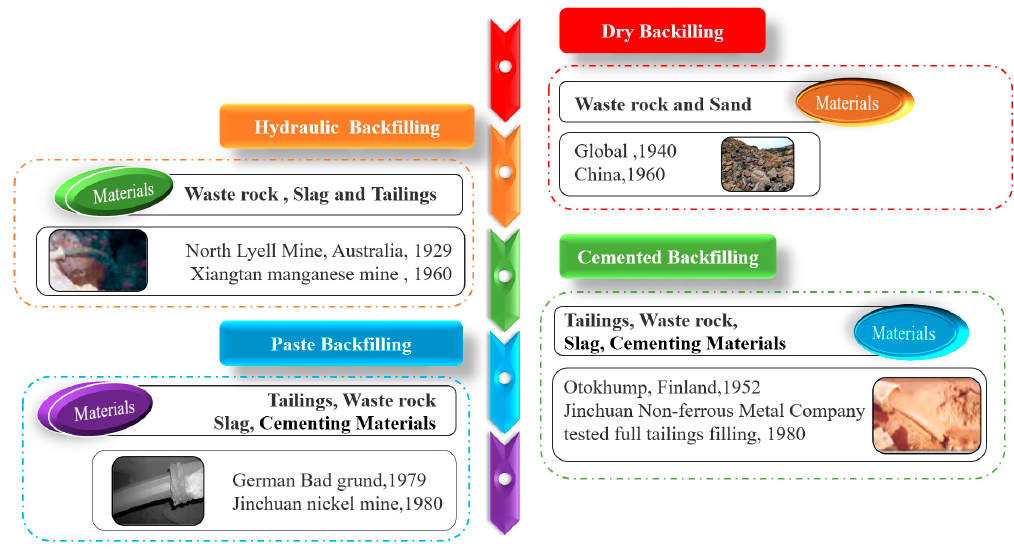
Figure 2. Development history of backfilling mining method.